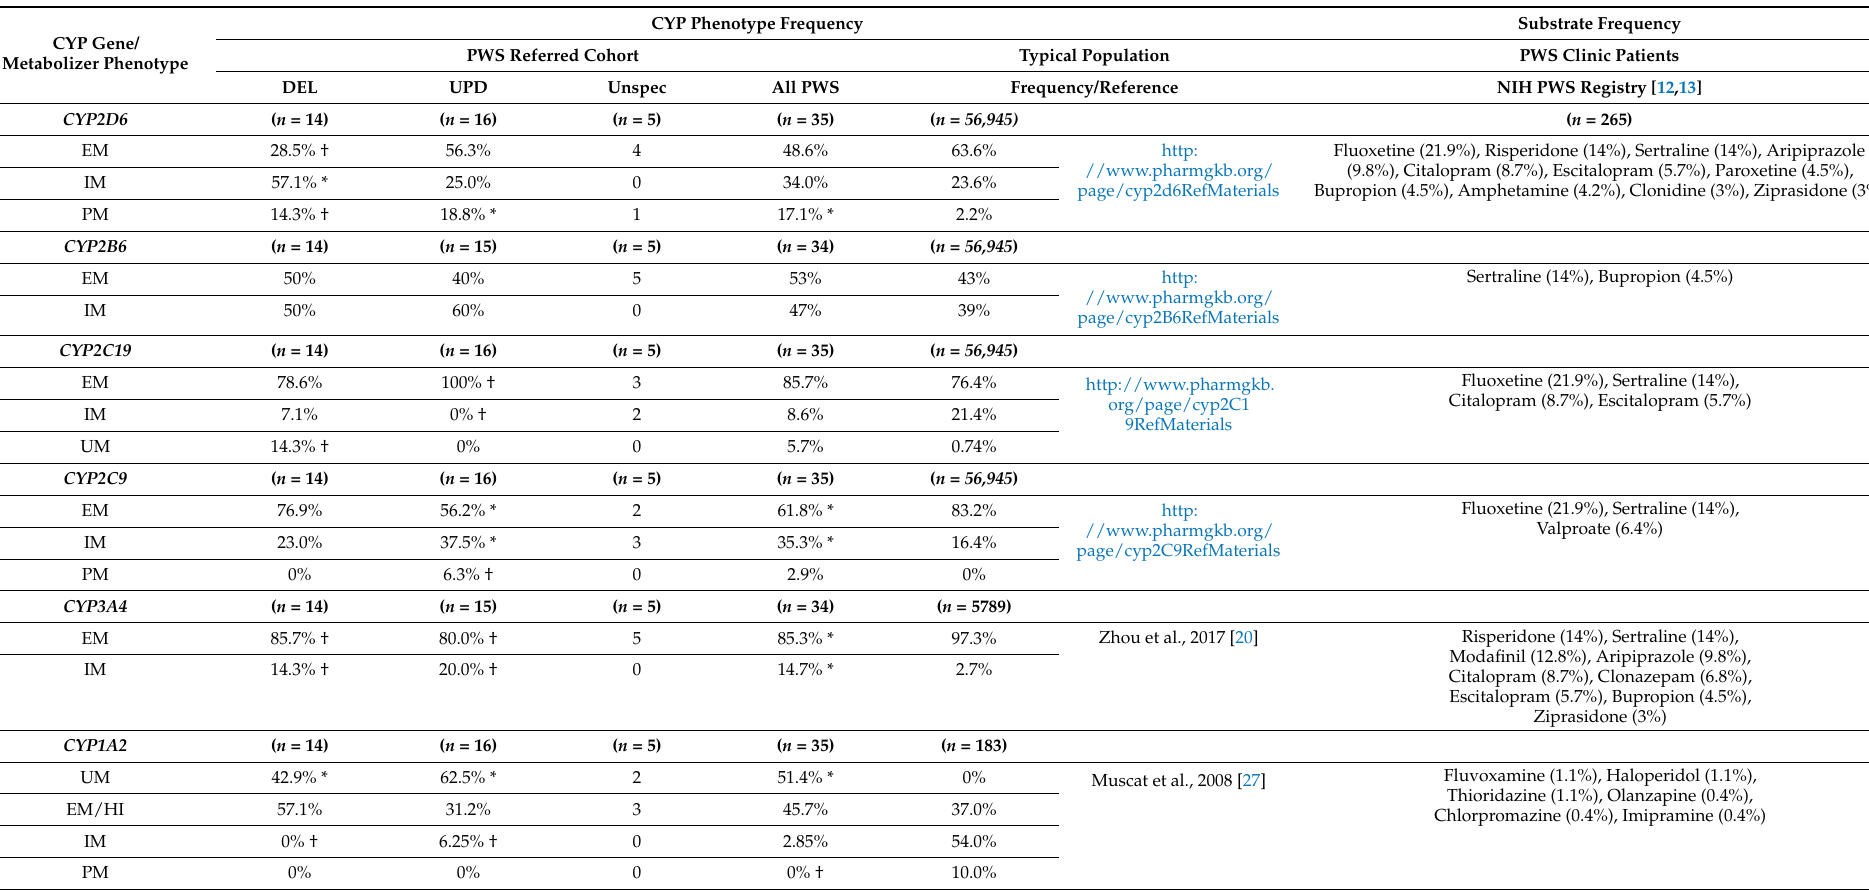
Table 1. Frequencies of CYP phenotypes in PWS cohort compared to a typical population, and substrates most likely to be affected based on drug utilization data from the NIH PWS